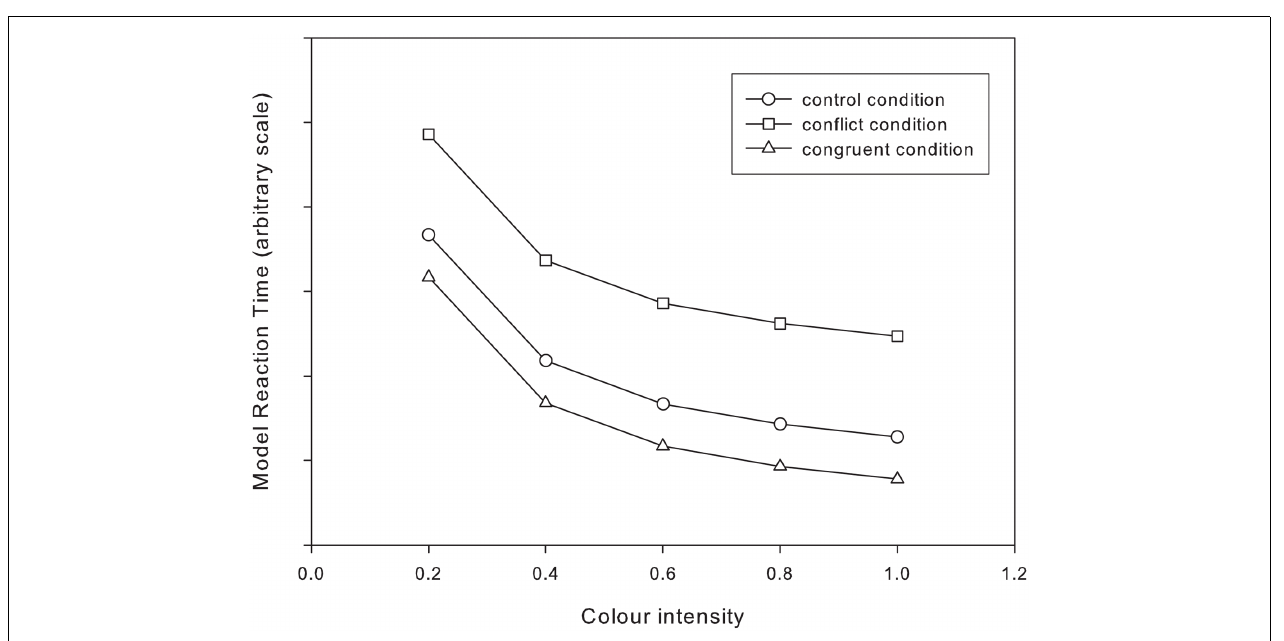
FIGURE 6 |Two stage model with locked inputs: simulated reaction times for the standard Stroop task across a range of color intensities.